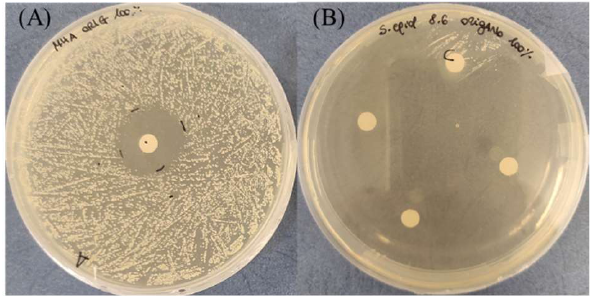
Figure 9. Inhibition effect due to a single ( A ) or three paper disks ( B ) impregnated with 100% oregano EO against S. epidermidis . In ( B ), a control disk with TEGO 1.5% (labeled “C”) was present.